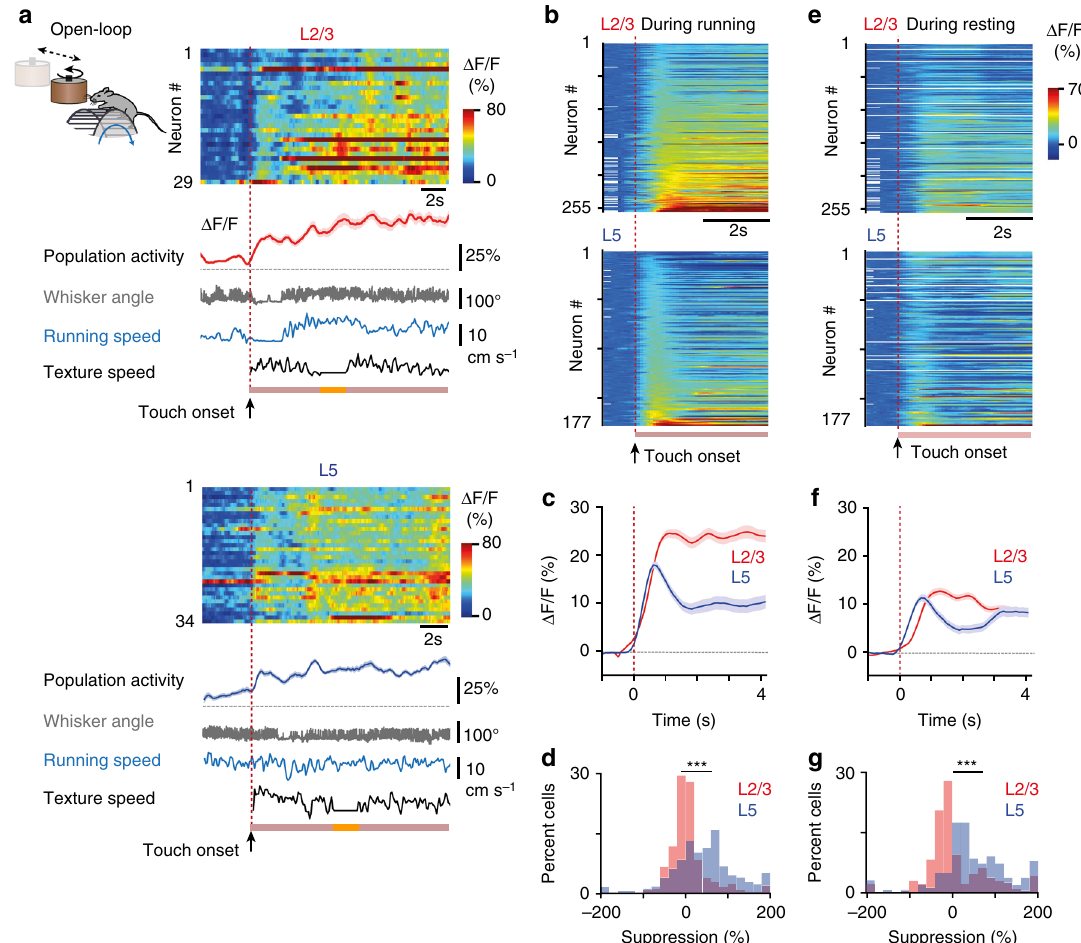
Fig. 4 Touch-evoked responses under Open-loop condition. a Population dynamics in L2/3 (left) and L5 (right) neurons for two example trials under Open- loop condition. The heat map represents Δ F / F calcium transients in pseudo-color code. Below the population mean Δ F / F trace (solid line, ±s.e.m.) are whisker angle (gray), running speed (blue), and texture speed (black). Touch onsets are indicated by red vertical dotted lines; pink bars represent periods of texture contact; orange segment is the period where texture rotation is brie fl y stopped. Imaging fi eld of views are the same as in Fig. 3a, with identical neuron numbers for L2/3. In L5 some neurons were not captured in the corresponding imaging session, hence the smaller number of neurons. b Of the touch-responsive neurons in Open-loop condition 255 of 342 L2/3 neurons and 177 of 236 L5 neurons had touch events during running. Heat maps show touch onset responses of these neurons in L2/3 (top) and L5 (bottom) during running. Initial white segments correspond to NaN values for neurons with very short pre-touch periods. c Population averages (±s.e.m.) of touch-aligned Δ F / F traces during running. d Distribution of percent suppression of touch responses during running. Mean suppression was 8.1 ± 2.9% and 44.1 ± 5.6% for L2/3 and L5 neurons, respectively ( p = 1.3 × 10 − 16 , Wilcoxon rank sum test). e Heat maps show touch responses that occurred during resting for the same neurons shown in ( b ). Neurons that did not have touch events during resting conditions are shown as white rows in heat maps. f Population averages (±s.e.m.) of touch-aligned Δ F / F traces during resting (245/342 L2/3 neurons, red, and 167/236 L5 neurons, blue). g Mean suppression was 6.4 ± 4.4% for L2/3 and 49.8± 6.3% for L5 neurons,